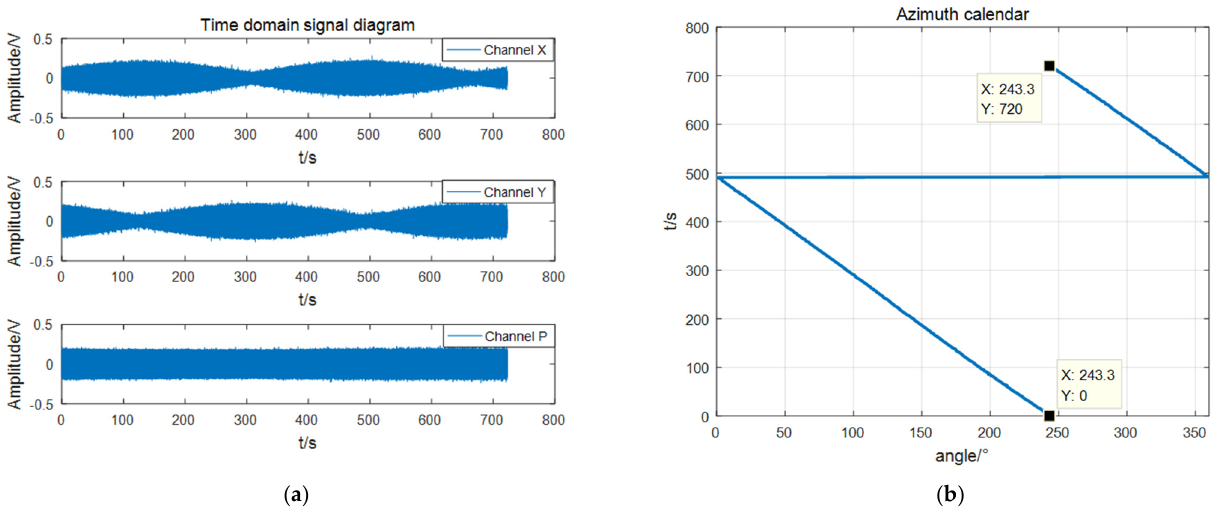
Figure 12. Signal processing results: ( a ) time domain diagram of three-channel signals; ( b ) azimuth history diagram of the measured target.